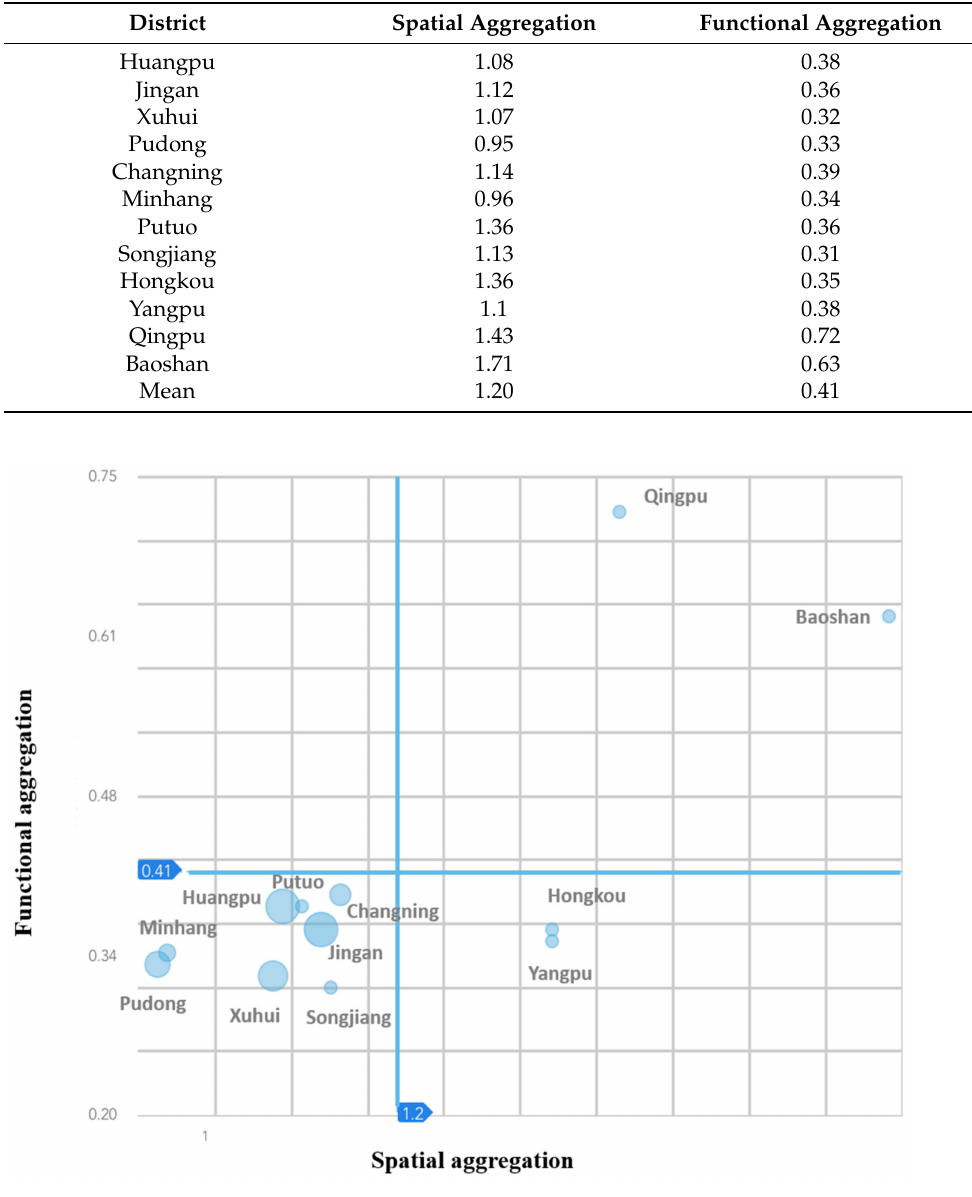
Figure 7. Quadrants of spatial and functional aggregation degree of 12